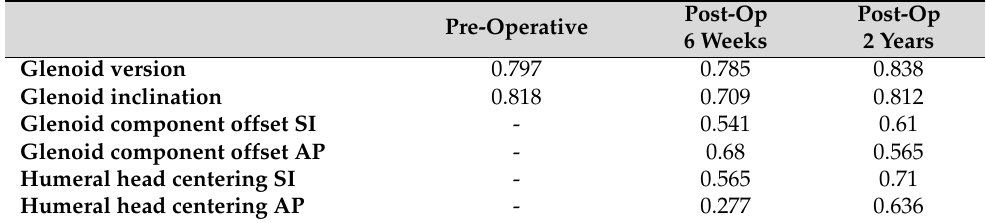
Table 3. Inter-rater reliability of radiographic evaluations assessed via intraclass correlation coeffi- cients